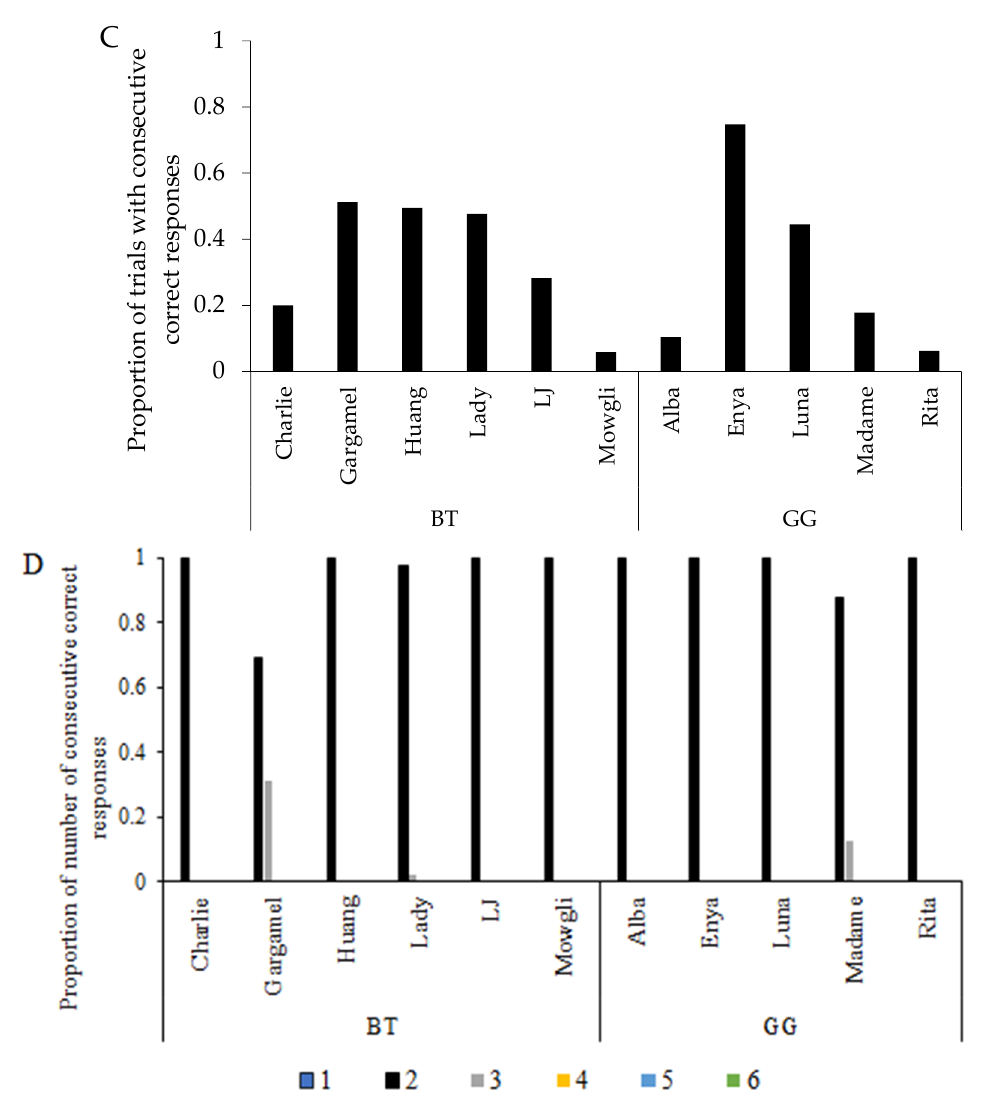
Figure 10. Search order in pattern A. A parrot may open another well by either going forward or sideways (see Figure 4). The proportion of ( A ) sideways movement (from the first to the second choice), ( B ) sideways responses that lead to incorrect responses; ( C ) trials with consecutive correct responses made on the first six responses; and ( D ) the consecutive number of correct responses made in the first six choices (ranged from 1–6, coded in different colour).